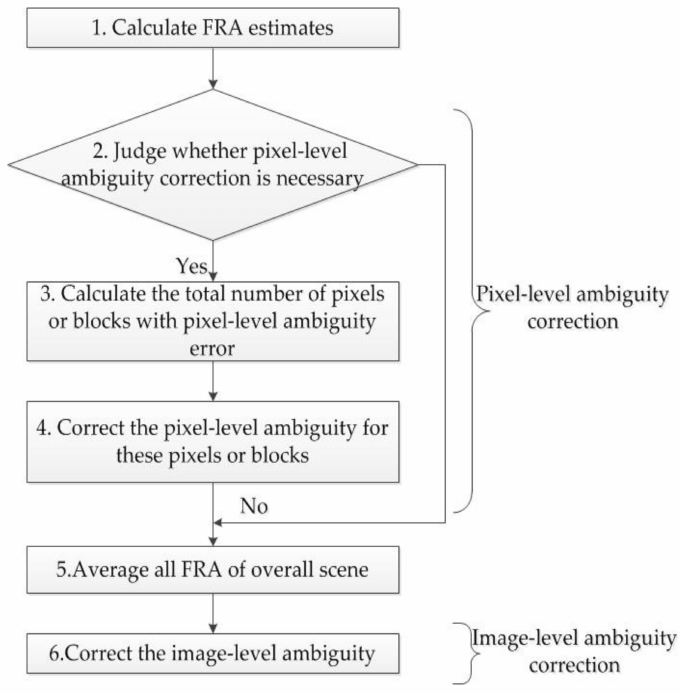
Figure 7. A flow chart of FRA ambiguity